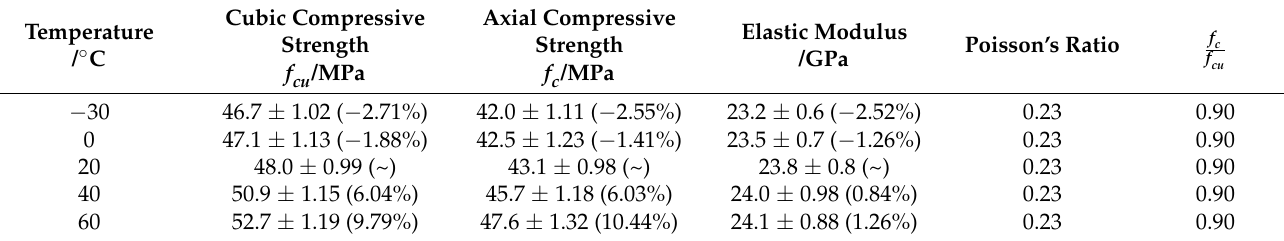
Table 5. Feature parameters of compressive property for HDC.